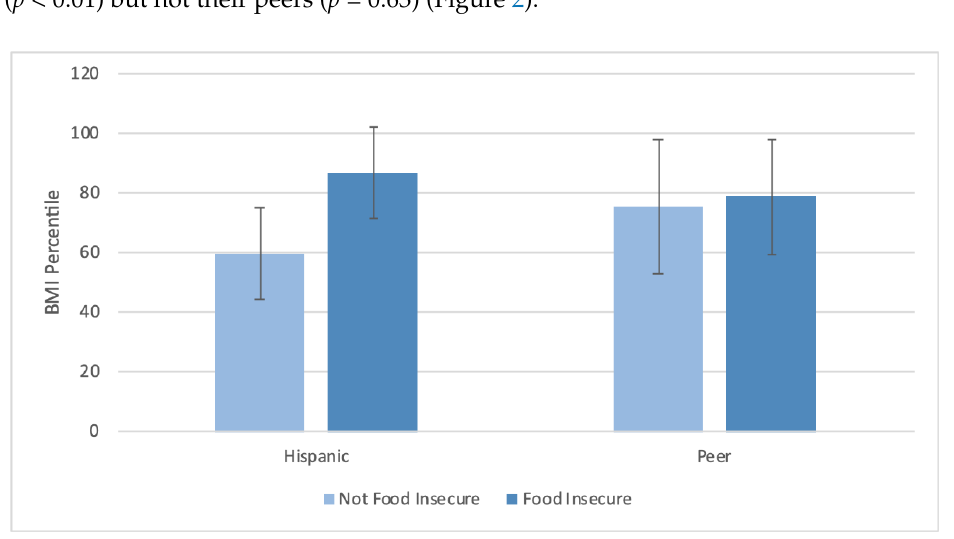
Figure 2. BMI percentile in Hispanic versus peer adolescents. p ethnicity = 0.68, p food insecurity < 0.01, p interaction = 0.04. p food insecurity for Hispanic adolescents < 0.01. p food insecurity for peer adolescents = 0.63. Mean ± SD are displayed.